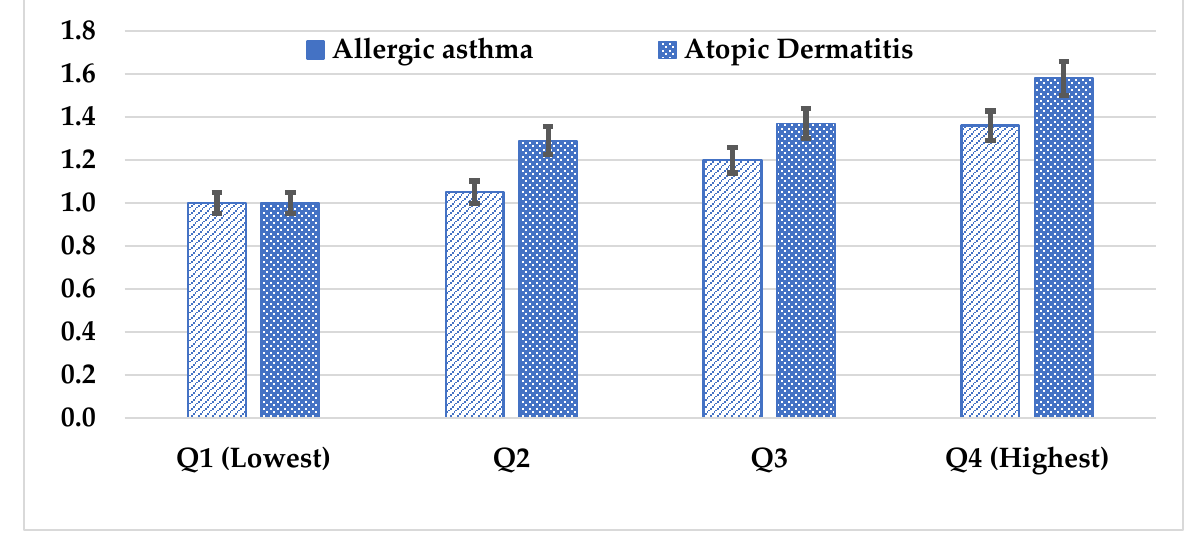
Figure 3. The association between SES and healthcare utilization for children with allergic conditions. Adjusted odd ratio with age, gender, parental education and occupation, residence, and health insurance.